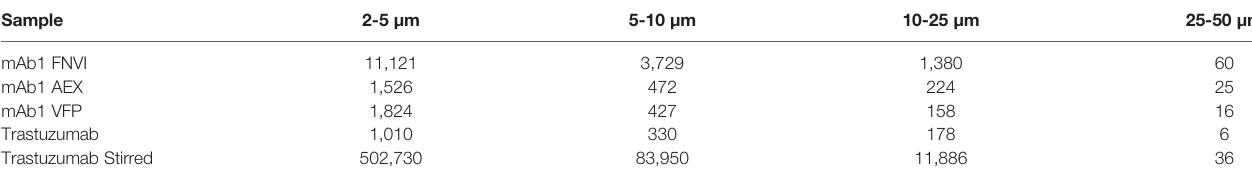
TABLE 1 | Micro fl ow imaging analysis of antibody aggregates: Comparison of spontaneously forming aggregates from upstream processing. Sample